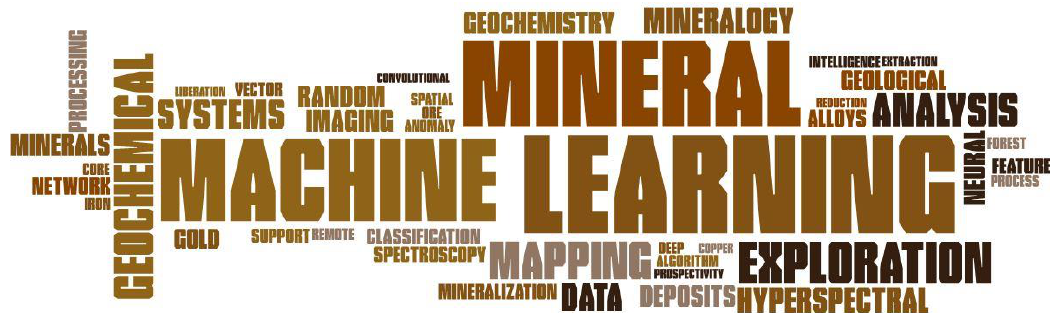
Figure 7. Frequently used words in the author and index keywords of the reviewed papers.